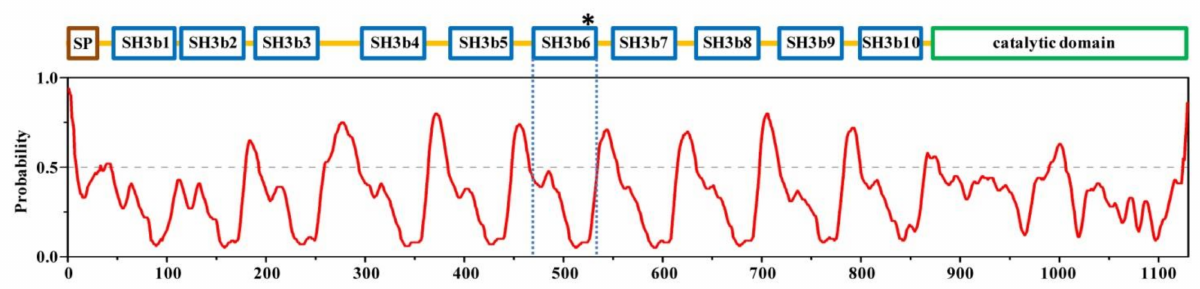
Figure 1. Architecture of CpAcp. Schematic domain structure of CpAcp with an analysis of structurally disordered probability at bottom. SP, signal peptide; SH3b, bacterial Src homology 3. The regions showing a probability above 0.5 (marked with a gray dashed line) are considered to be disordered. SH3b6 is highlighted with asterisk and blue dashed